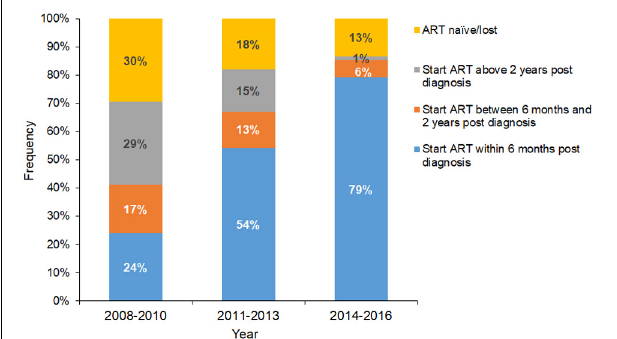
FIGURE 5 | Distribution and composition of the time lag between HIV infection diagnosis and ART initiation. Blue, orange, gray, and yellow columns represent ART initiation within 6 months of diagnosis, ART initiation between 0.5 and 2 years post diagnosis, ART initiation > 2 years post diagnosis, and ART naïve/lost,